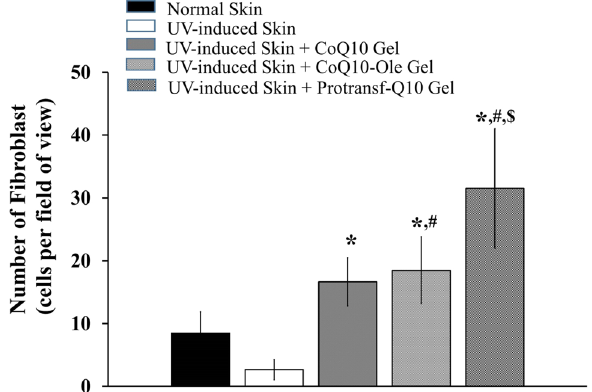
Figure 7. The number of fibroblasts of mice back skin without and with UV-induced photoageing after topically applied with saline (Normal skin and UV-induced skin), CoQ10-loaded Emulgel, CoQ10 dissolved in oleic acid (CoQ10-Ole) Emulgel, and protransfesomal CoQ10 (Protransf-CoQ10) Emulgel once every 2 days for 2 weeks. * P < 0.05 compared to UV-induced skin, # P < 0.05 compared to Normal Skin, $ P < 0.05 compared to CoQ10-Ole treated